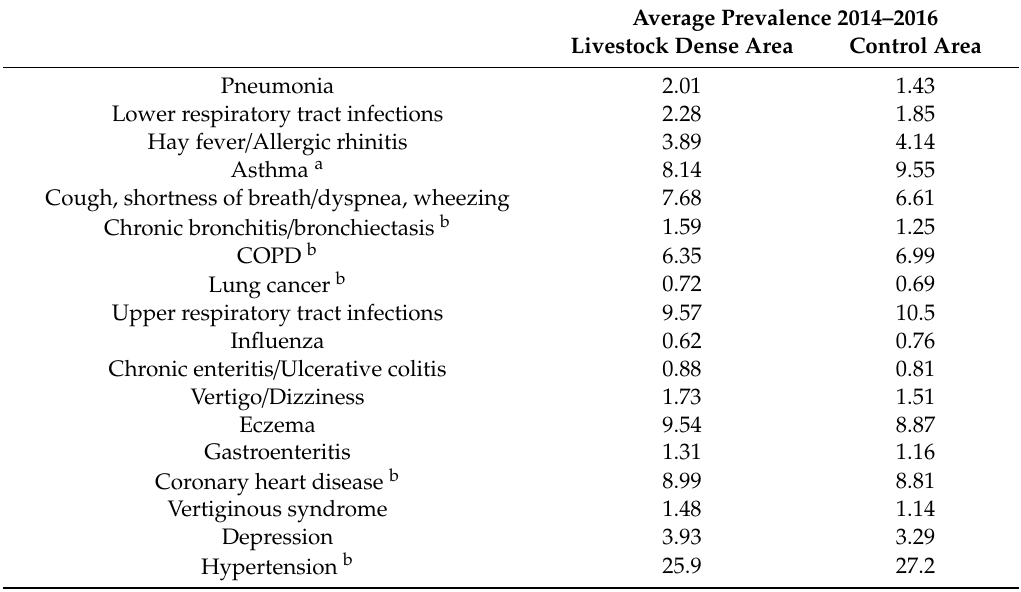
Table A5. Averageprevalence(%)ofhealthconditionsinthestudyandcontrolareafortheperiod2014–2016.